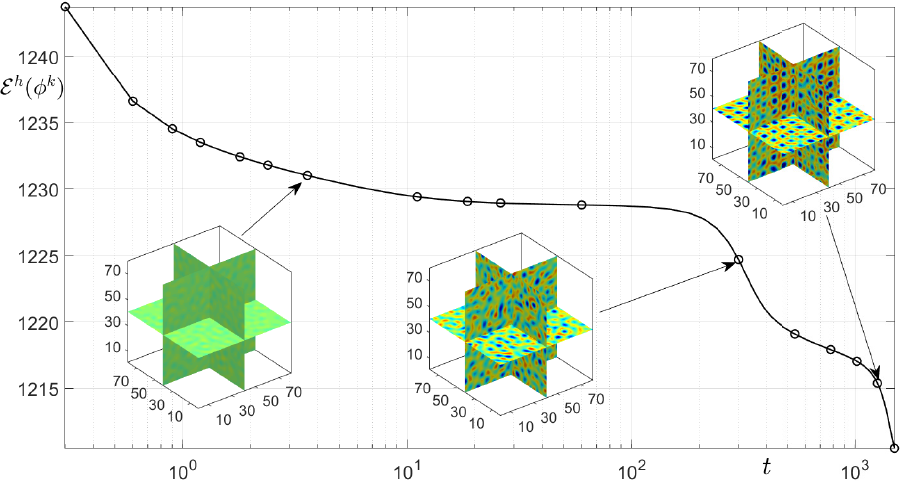
Figure 36. Energy decay over time of Equation (87) via classical PFC model with the initial condition (88) . Each snapshot illustrates the evolution at t = 4, 400, and 1250,